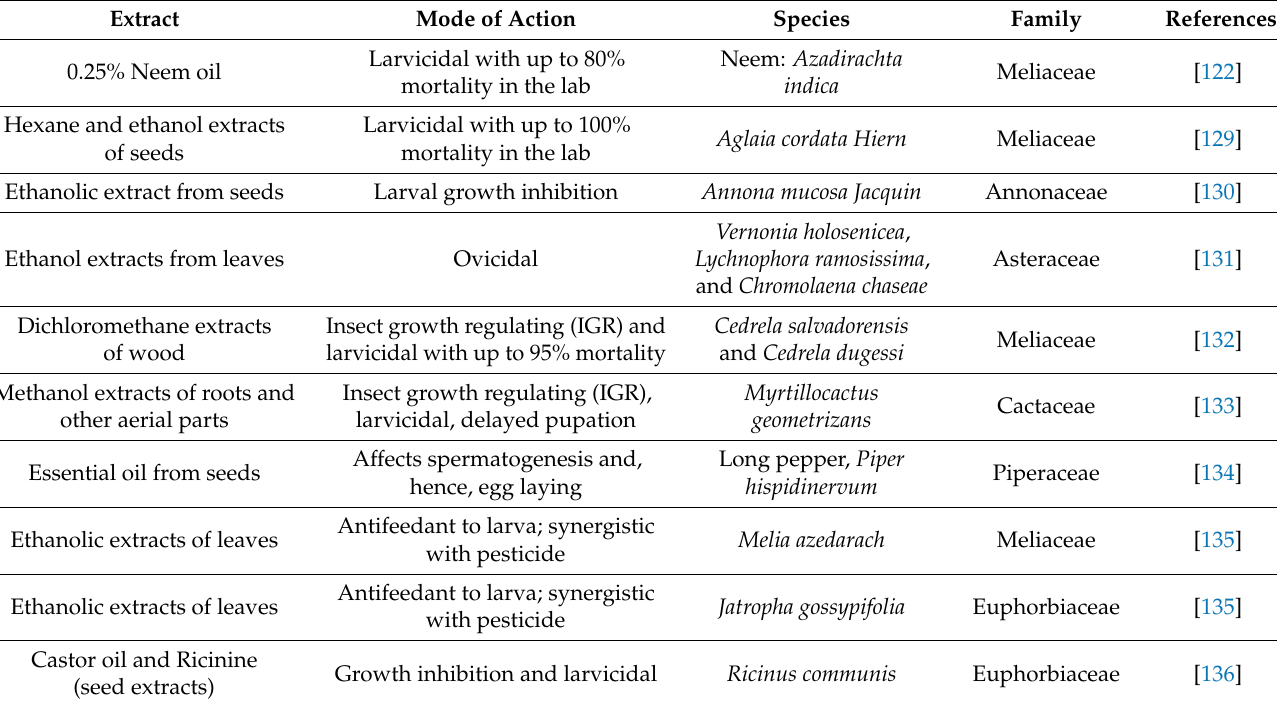
Table 3. Potential botanical pesticides against